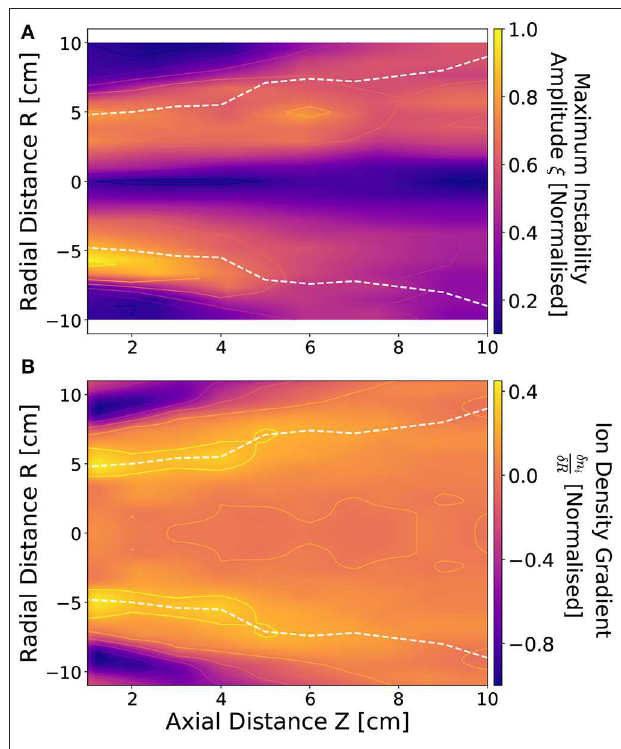
FIGURE 3 | Normalized (A) maximum instability amplitude ξ and (B) radial ion density gradient δ n i δ downstream of the DL between 1 ≤ Z ≤ 10 cm and R − 10 ≤ R ≤ 10 cm. White dashed lines denote the approximate location of beam-conic interface. Operating conditions: helicon antenna supplied P rf = 300 W at ν rf = 13.56 MHz employing 0.25 mTorr argon with I 1,2 = 6 A solenoid